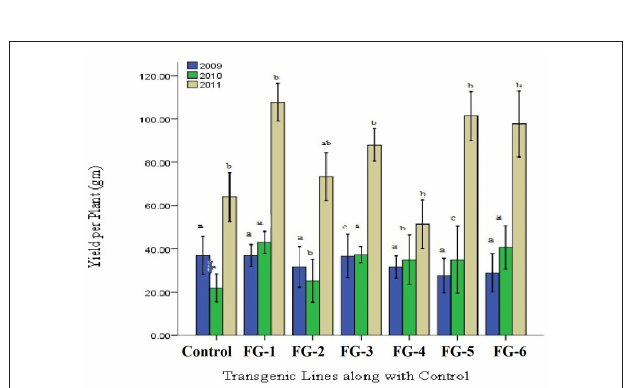
FIGURE 9 | Comparison of yield per plant of transgenic and control lines (T 0 , T 1 , and T 2 Generations). Lane 1: Control Plant, Lane 2–7: yield per Plant of Different GhEXPA8 transgenic cotton Plants, blue color represent yield analysis at T 0 generation, green color indicated yield analysis at T 1 generation, brown color highlight yield analysis at T 2 generation, Note: Bar determined the standard error.